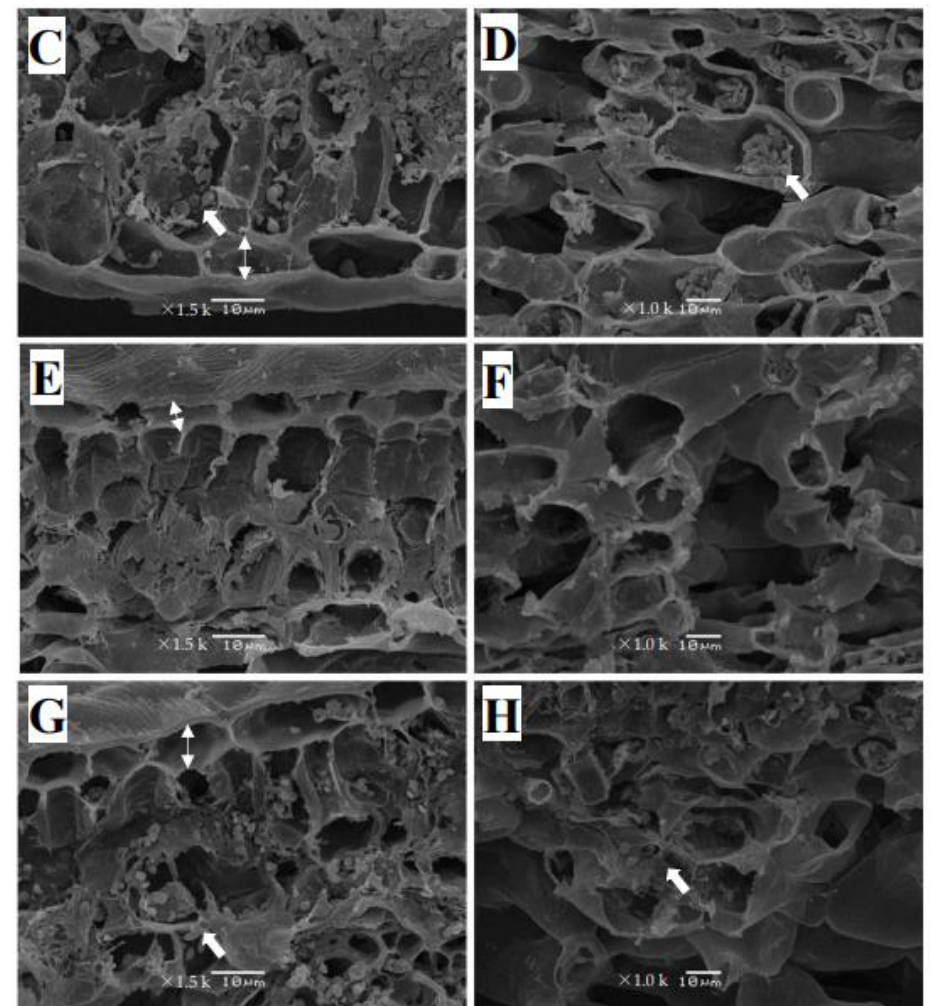
Figure 2. The SEM images of 0.5 µM ( A , B , E , F ) and 300 µM Cu-treated ( C , D , G , H ) leaves of two citrus species. C. sinensis : ( A – D ); C. grandis : ( E – H ). Images ( A , C , E , G ) show epidermis and palisade tissues of citrus leaves. Images ( B , D , F , H ) show the spongy tissue. The granules in cells labeled by arrows are starch granules. The two-way arrow represents the average thickness of the leaf epidermis. The scales in the figures represent 10 μm.